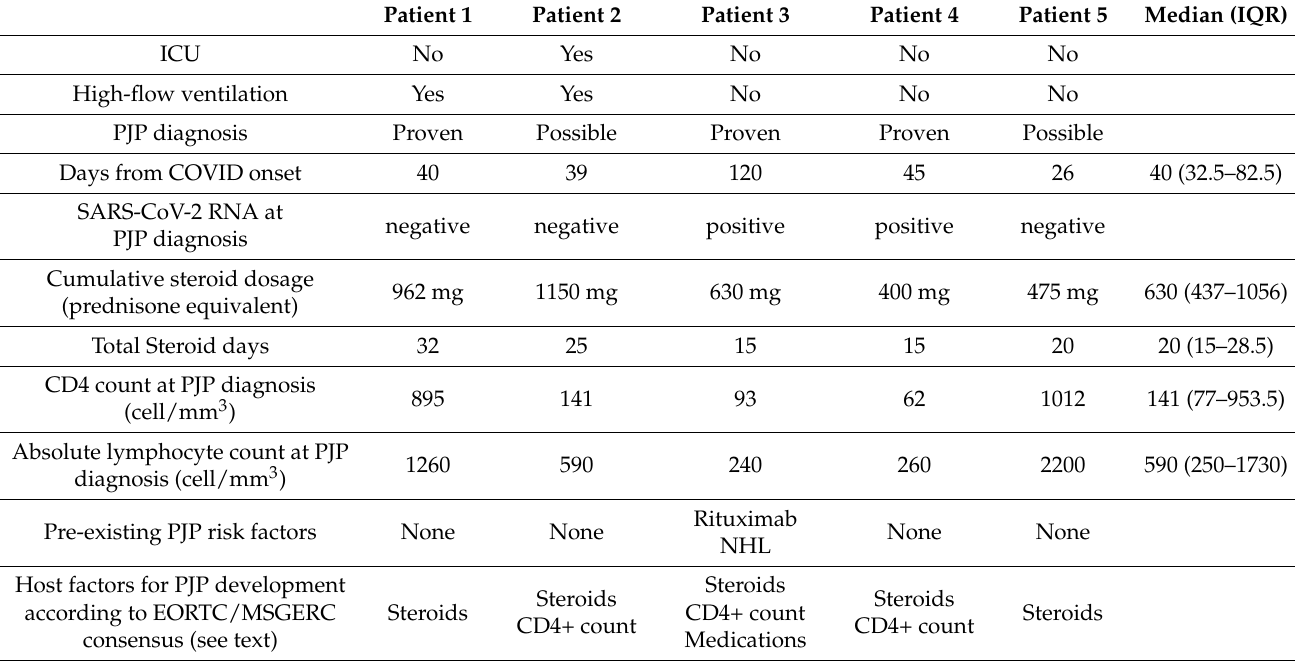
Table 1. Patients’ characteristics. ICU = Intensive Care Unit; NHL = Non-Hodgkin lymphoma; PJP = Pneumocystis jirovecii